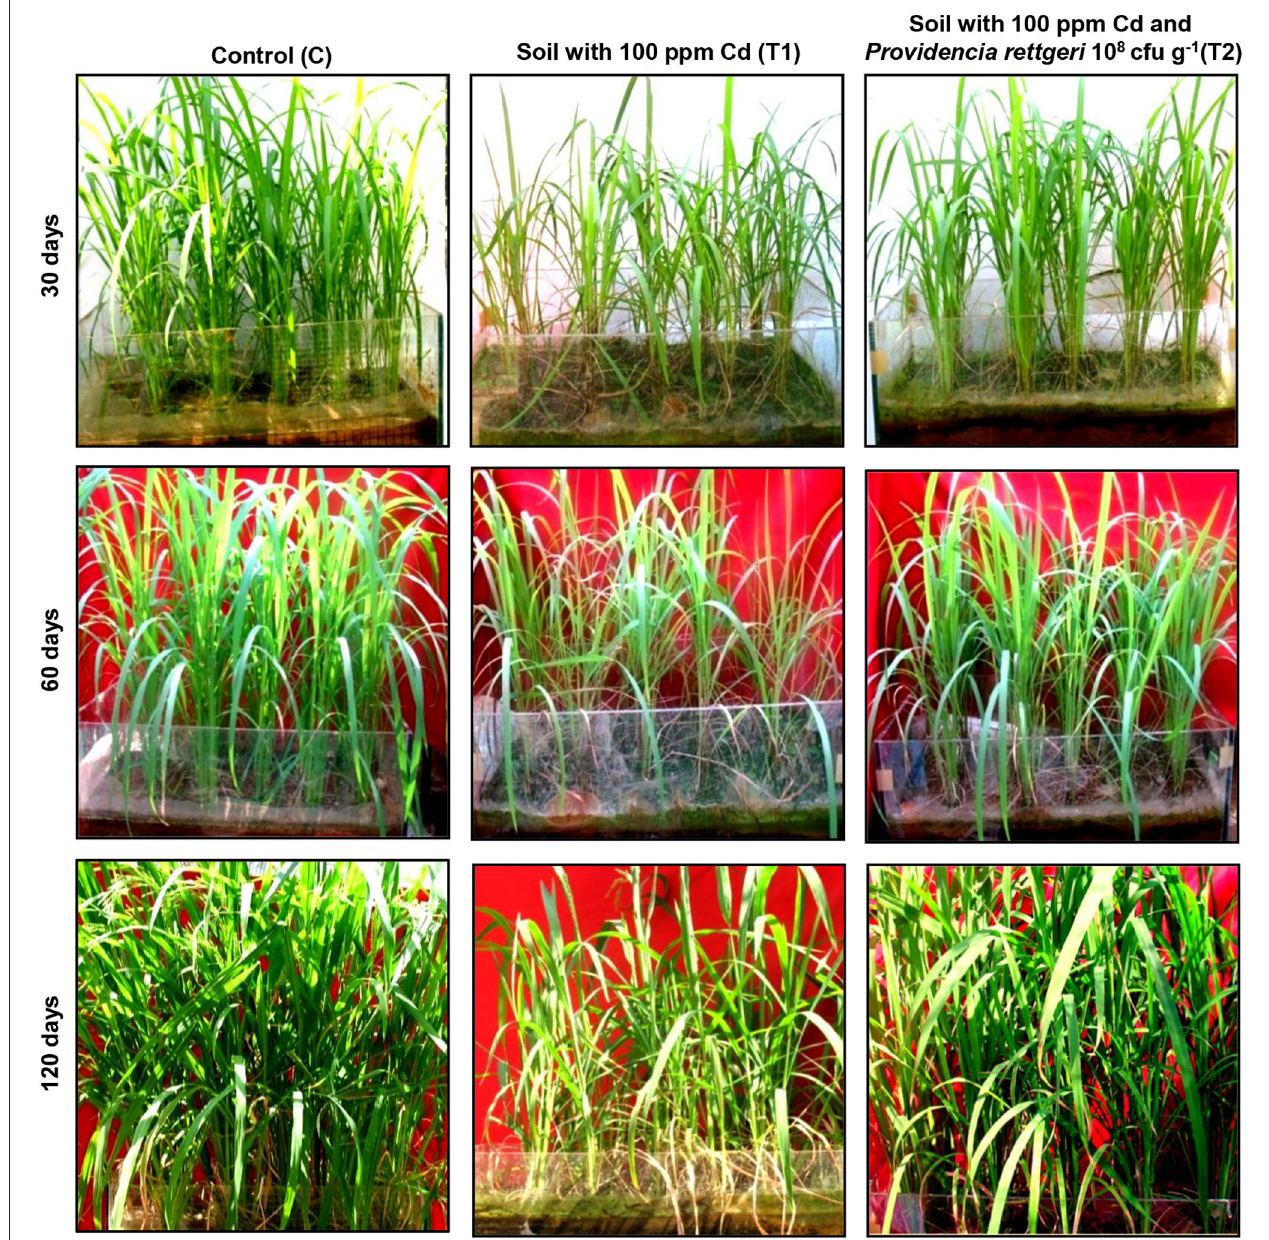
FIGURE 4 | Effect of P. rettgeri on Cd toxicity in rice plants. The images show the growth pattern of the rice plants grown either in the absence of Cd (C), in soil spiked with 100 ppm Cd (T1), or in soil spiked with 100 ppm Cd and 10 8 P. rettgeri cells per gram of soil (T2). The images were taken at the different stages of plant development. For larger images, refer to Supplementary Figure S6